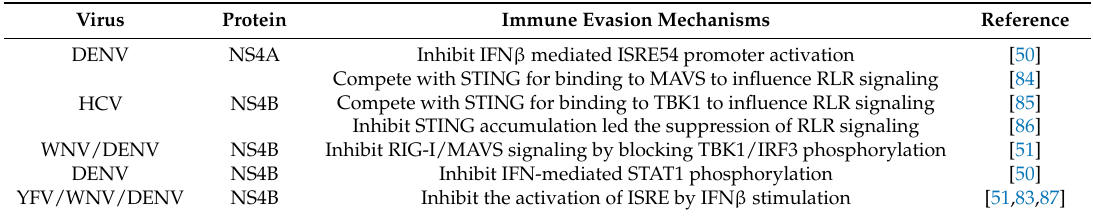
Table 3. Immune evasion by flaviviridae